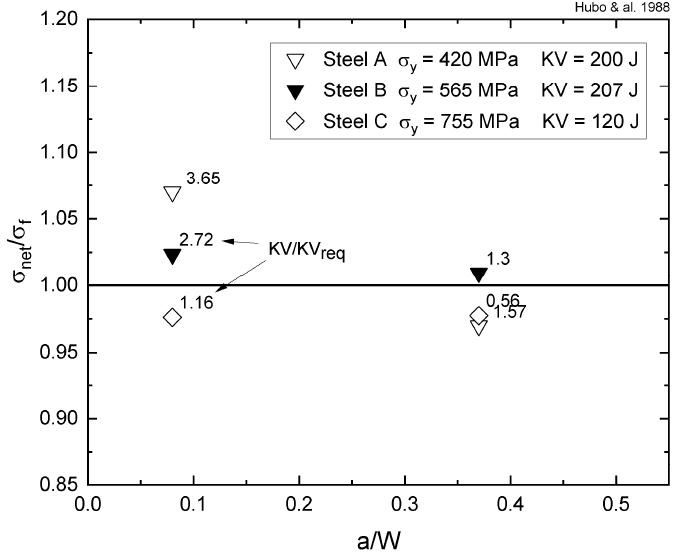
Figure 12. Proportional net section stress values divided by flow stress for the data in Figure 9 as a function of relative crack length and related to ratio between the Charpy-V impact energy and estimated required impact energy to obtain the plastic limit load.